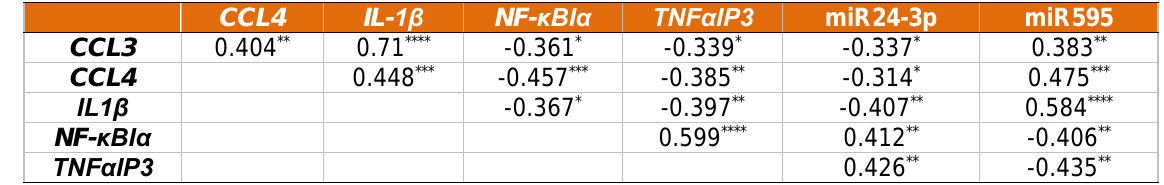
Table 3: Pearson correlation between the levels of the different parameters in CAD